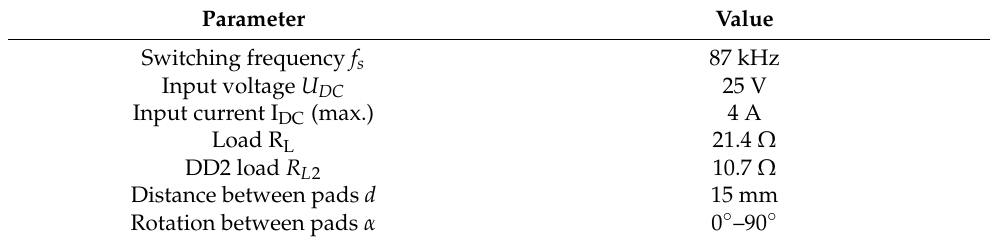
Table 4. Small scale prototype parameters.